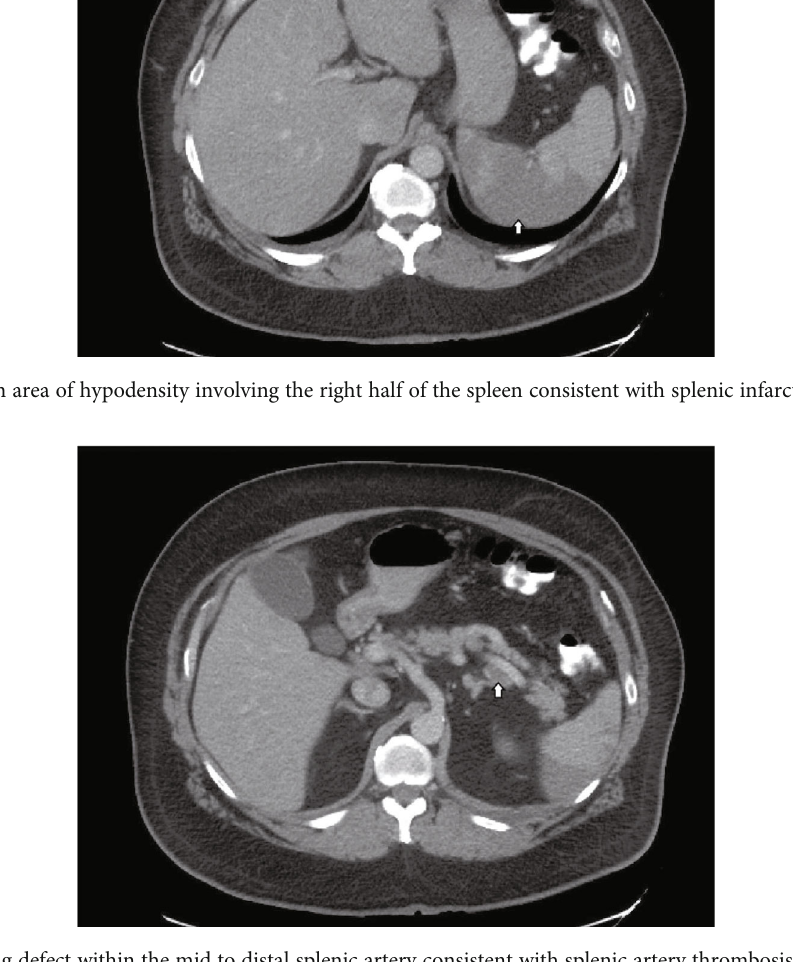
Figure 2: A fi lling defect within the mid to distal splenic artery consistent with splenic artery thrombosis, transverse